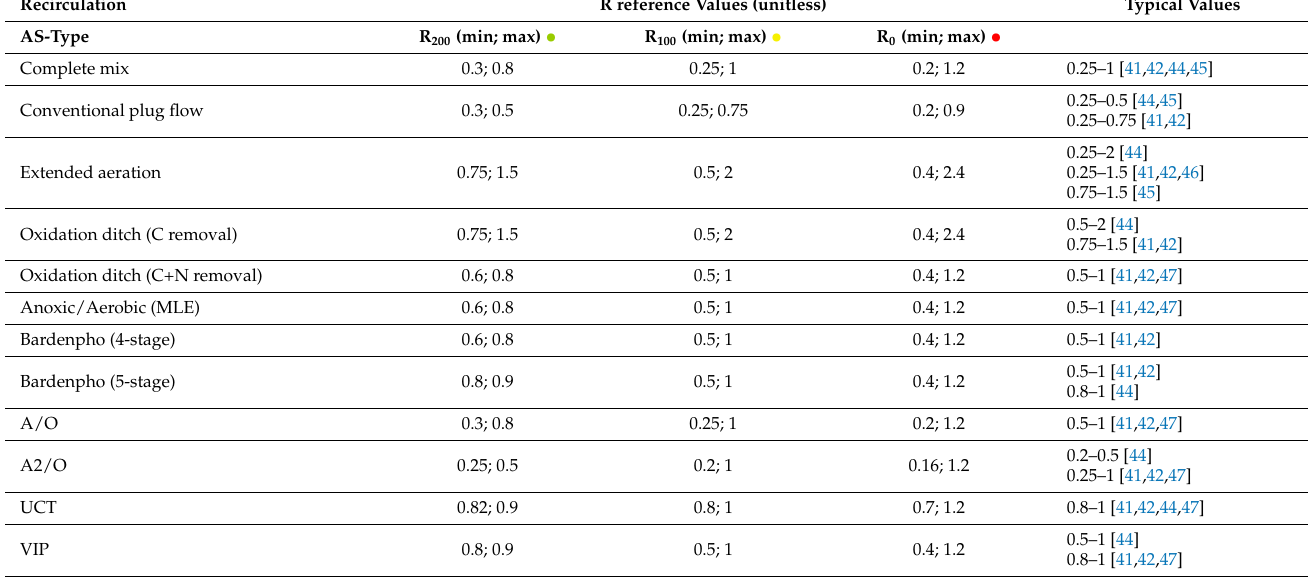
Table 7. The reference values for the return sludge ratio in the AS